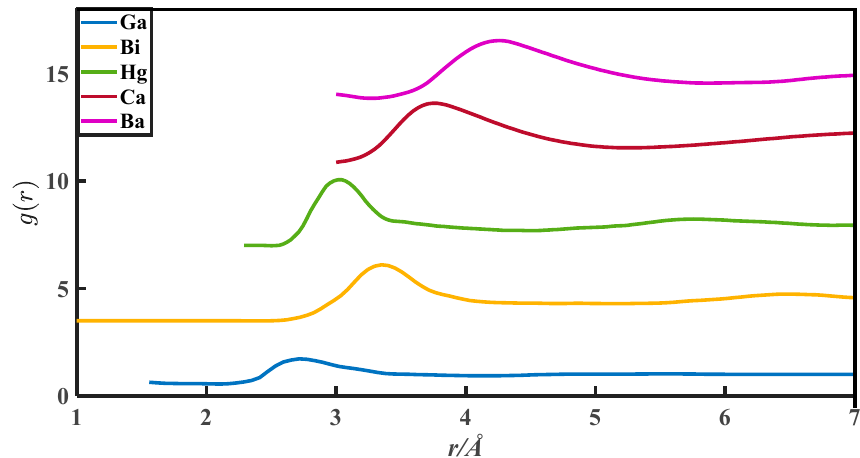
Figure 2. The pair distribution function of Ga, Bi, Hg, Ca, and Ba.